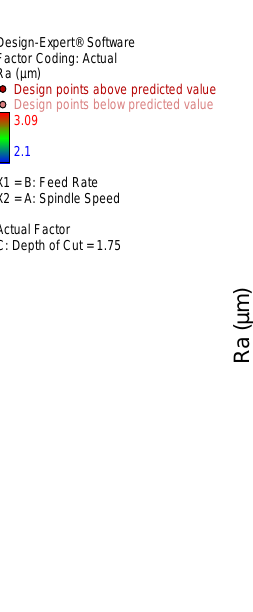
Fig. 12. Influence of Spindle speed & Feed rate on